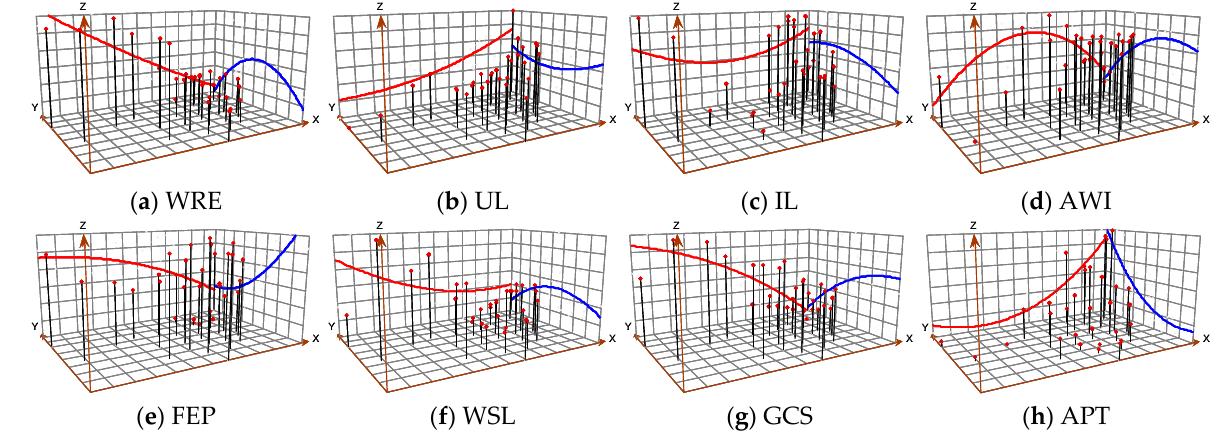
Figure 6. Spatial evolution characteristics of each influencing factor from 1997 to 2020. Note: The X-axis represents the direction of east longitude increments, that is, from west to east; the projection of XZ plane (red line) represents the variation trend of each influencing factor in different regions from west to east. The Y-axis represents the direction of north latitude increments, that is, from south to north; the projection of YZ plane (blue line) represents the variation trend of each influencing factor in different regions from south to north; and the Z-axis represents the green efficiency of agricultural water use in each